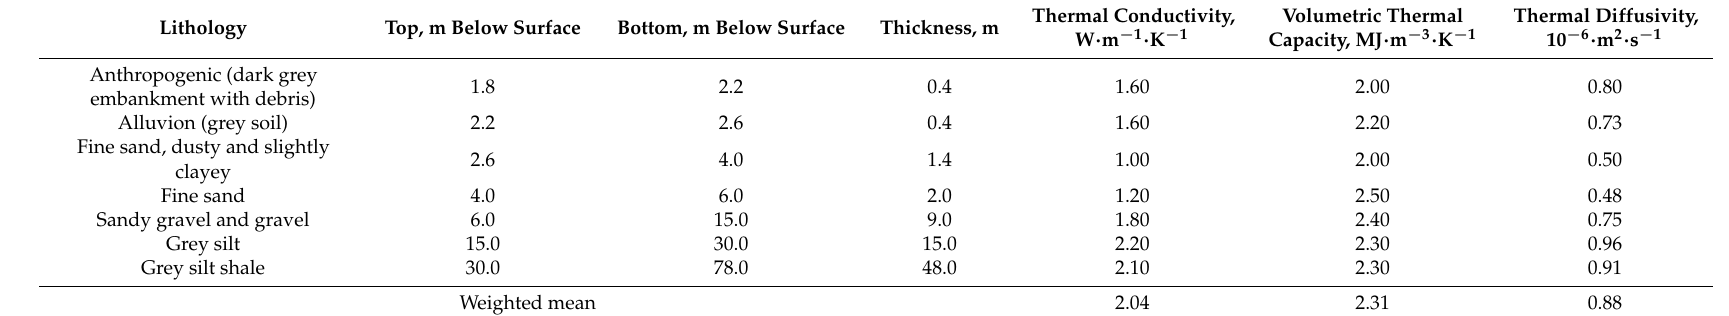
Table 3. Lithological profile of borehole at AGH-UST in Krakow, Poland